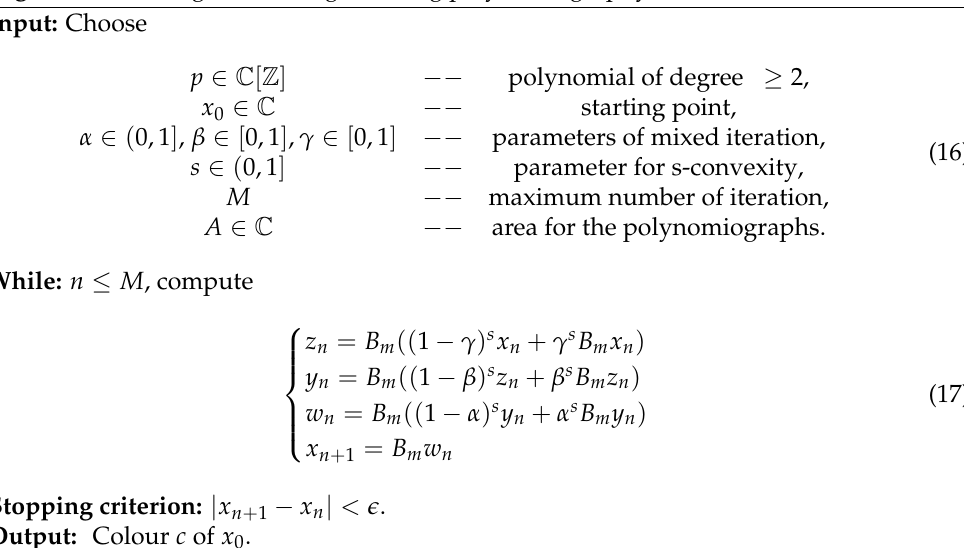
Algorithm 1 RK algorithm for generating